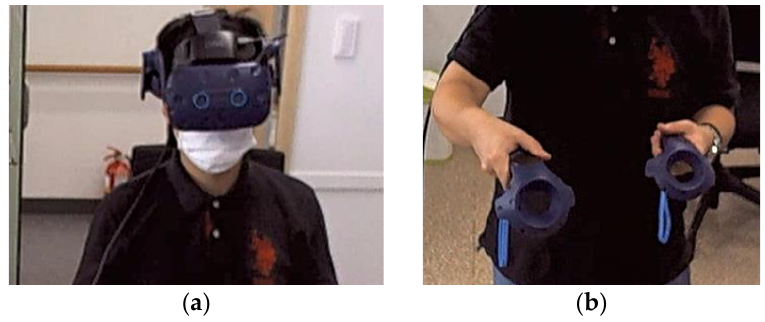
Figure 2. A screenshot of the head mounted display and controllers: ( a ) HMD; ( b ) controllers.